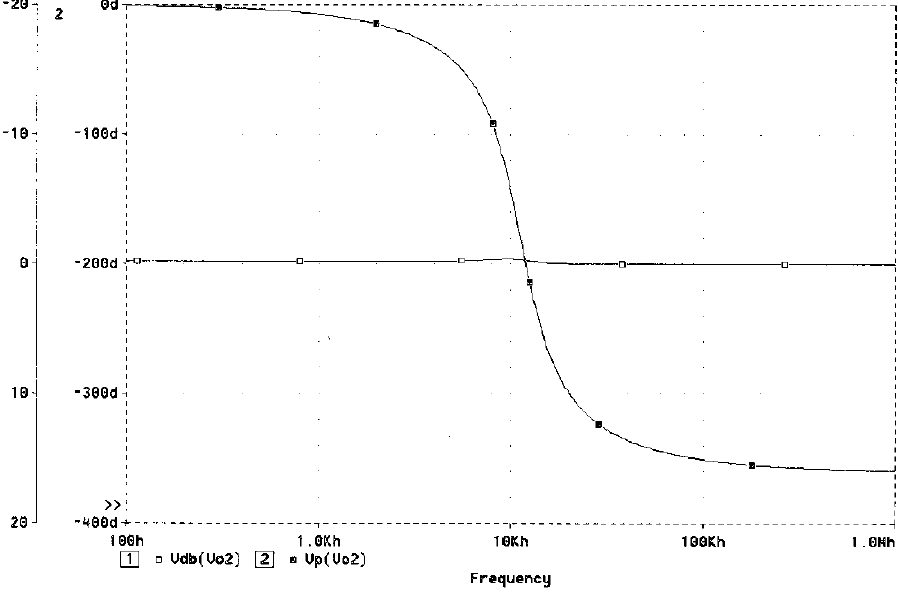
FIGURE 3 Simulation results of the allpass filter at V o 2 in Figure 1. — u — gain response; — j — phase